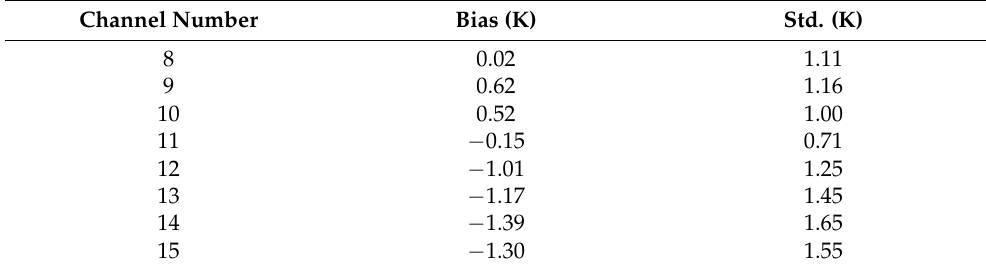
Table 3. Biases and standard deviations of Fengyun-4B/AGRI IR channels brightness temperature observations and RTTOV simulations over the ocean under clear-sky conditions and with satellite zenith angles less than 60° from June to November 2022.